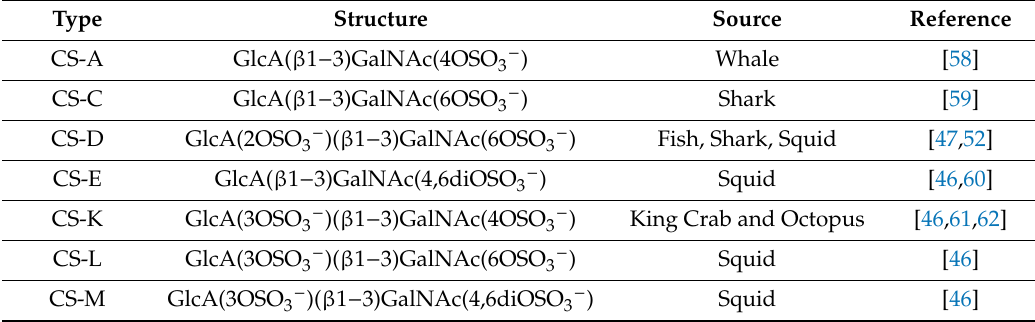
Table 1. Common and novel CS disaccharide units described by sulfation patterns and by common marine